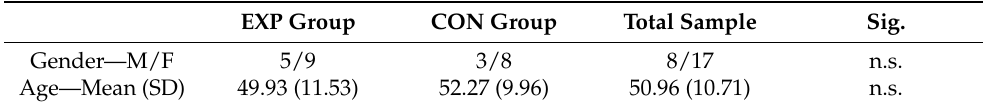
Table 1. Demographic data for the whole sample and for experimental and control groups, and significance of their between-group statistical